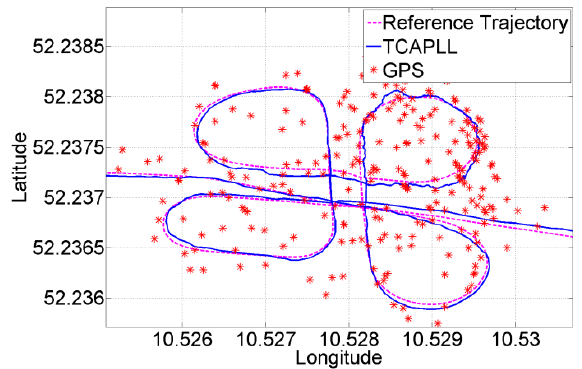
Figure 15. Position solutions when four SVs are visible.